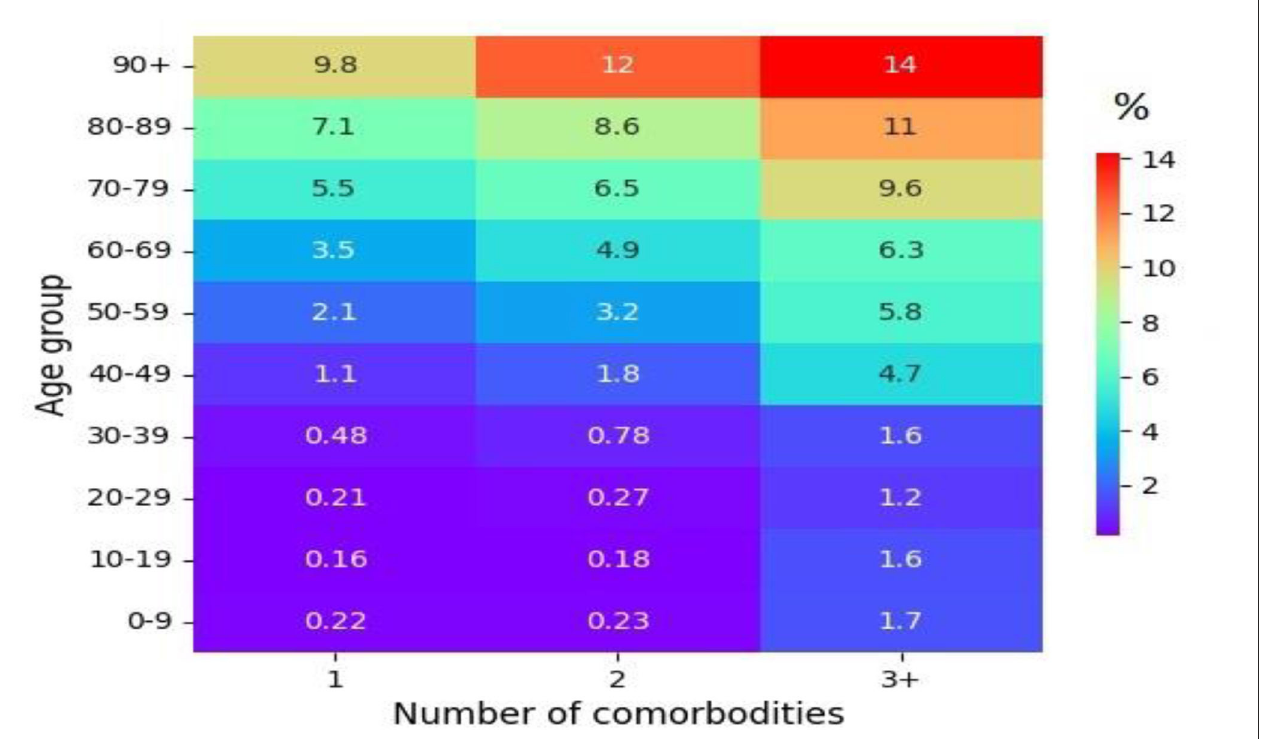
overreactive but ineffective immune alert system (40), all of which translated to the above-average severity of COVID-19 outcomes among the